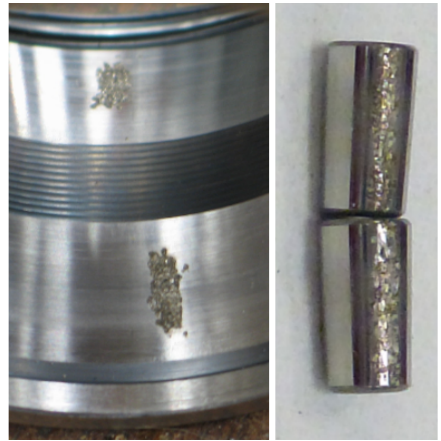
Figure 5. The induced scuffing on the bearing outer race ( left ) and the roller ( right